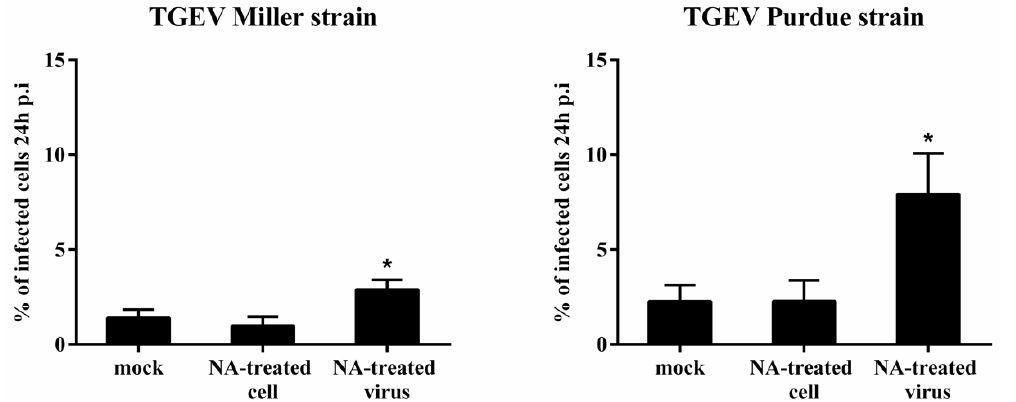
Figure 5. Effect of neuraminidase N (NA) treatment of enterocytes or virus on the infection of TGEV Miller and Purdue in enterocytes. The percentage of infection was evaluated 24 h post inoculation. Data are expressed as mean ± SD of the results of three separate experiments. Statistically significant differences in comparison with data from mock treatment are presented as * p < 0.05.